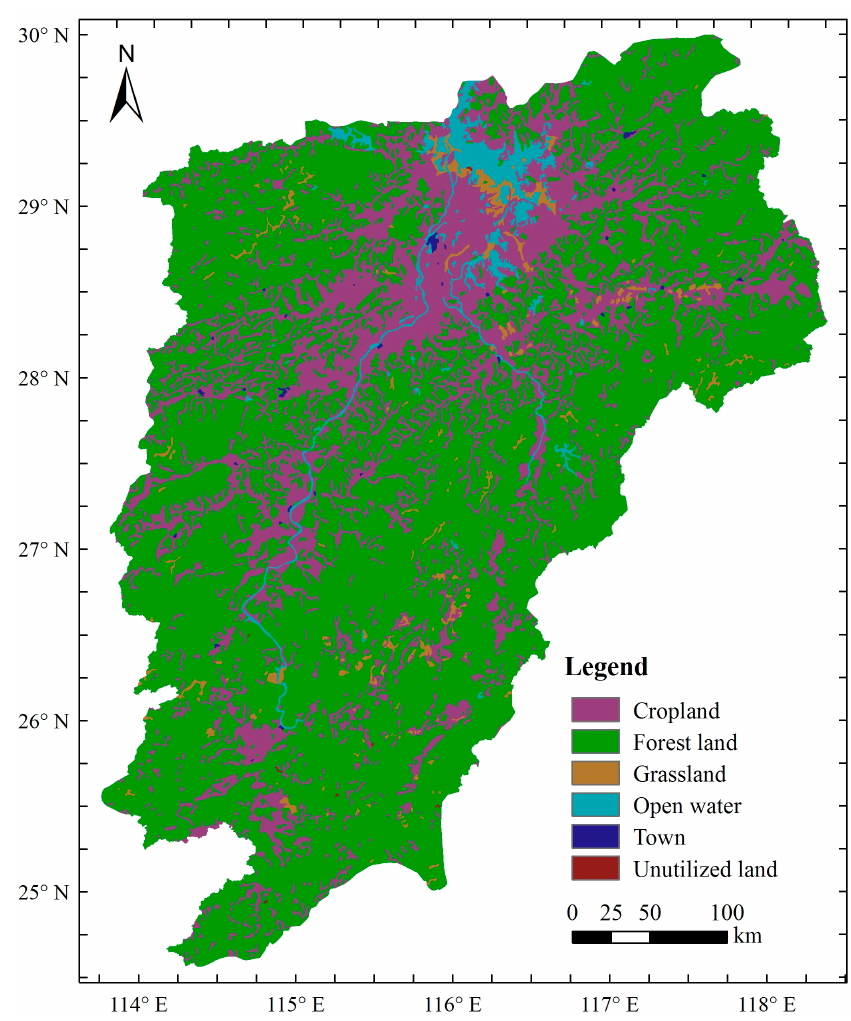
Figure 2. The land use map of Poyang Lake basin.